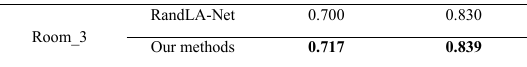
Table 2. Overall accuracy evaluation of each